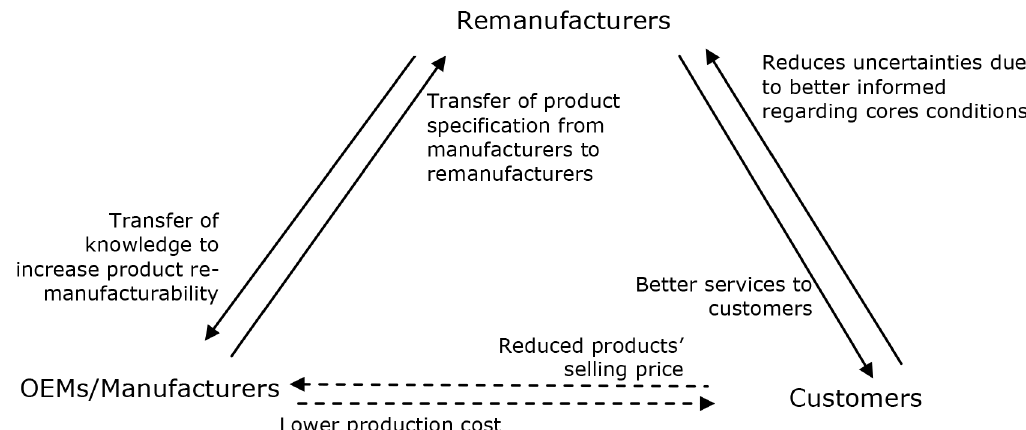
Figure 4. Benefits of PSS for actors involved in